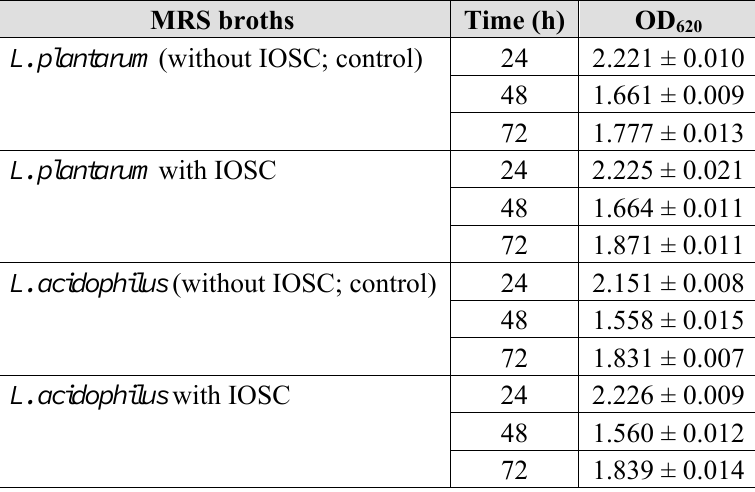
Table 3(b). The growth density OD 620 of